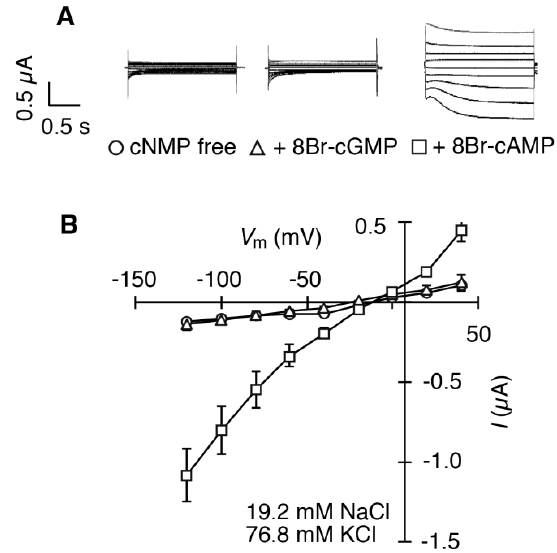
Figure 5. Current/voltage relationship of HvCNGC2-3 -expressing oocytes in a 1:4 mixture of Na + and K + media. Currents were recorded by the two-electrode voltage-clamp technique in a bathing solution containing 19.2 mM NaCl and 76.8 mM KCl in the absence of a pre-incubation with cyclic nucleoside monophosphates (cNMP-free, circles), and in the presence of a pre-incubation with 10 µM 8Br-cGMP (triangles) or 8Br-cAMP (squares) for 30 min. ( A ) representative raw recording traces; ( B ) current/voltage curve. Error bars indicate standard deviation ( n = 9, 13 and 6 for cNMP-free, cGMP and cAMP, respectively). I , membrane current. V m, membrane potential.